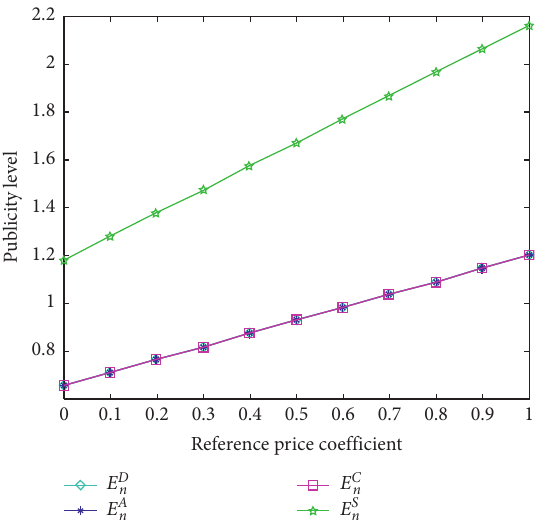
Figure 5: The impact of consumer reference price effects on the level of